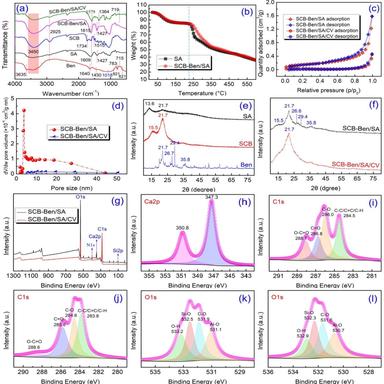
(a) FTIR spectra of Ben, SA, SCB, SCB–Ben/SA, and SCB–Ben/SA/CV. (b) TGA curves of SA and SCB–Ben/SA. (c) N2 adsorption–desorption isotherms and (d) pore size distributions of SCB–Ben/SA and SCB–Ben/SA/CV. (e) XRD patterns of SA, SCB, and Ben. (f) XRD patterns of SCB–Ben/SA and SCB–Ben/SA/CV. (g) Widescan XPS spectra of SCB–Ben/SA and SCB–Ben/SA/CV. (h) Ca2p spectrum of SCB–Ben/SA. C1s spectra of (i) SCB–Ben/SA and (j) SCB–Ben/SA/CV. O1s spectra of (k) SCB–Ben/SA and (l) SCB–Ben/SA/CV.